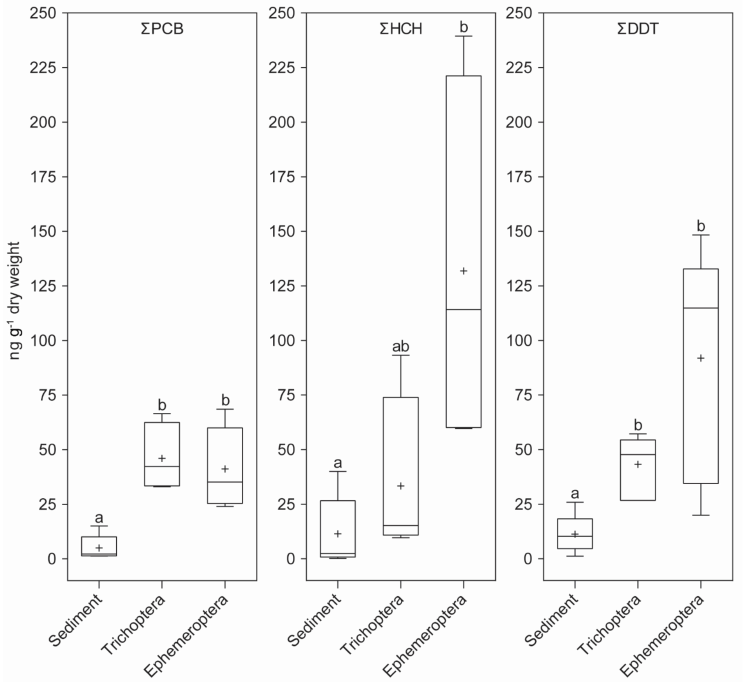
Figure 3. Significant differences in concentration between sediment, Trichoptera, and Ephemeroptera. Box plots with whiskers at the minimum and maximum values while the box is delimited by the 25th and 75th percentile with the median shown as a line and the mean as a plus sign. Different letters above the boxes indicate significant differences ( p <